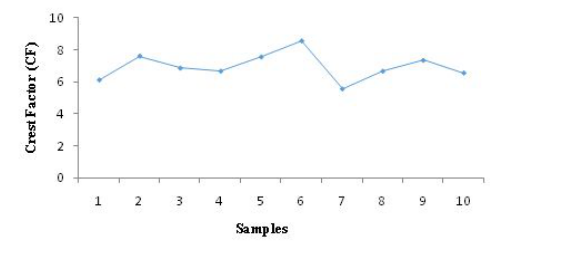
Figure 9: Crest Factor (CF) of the different